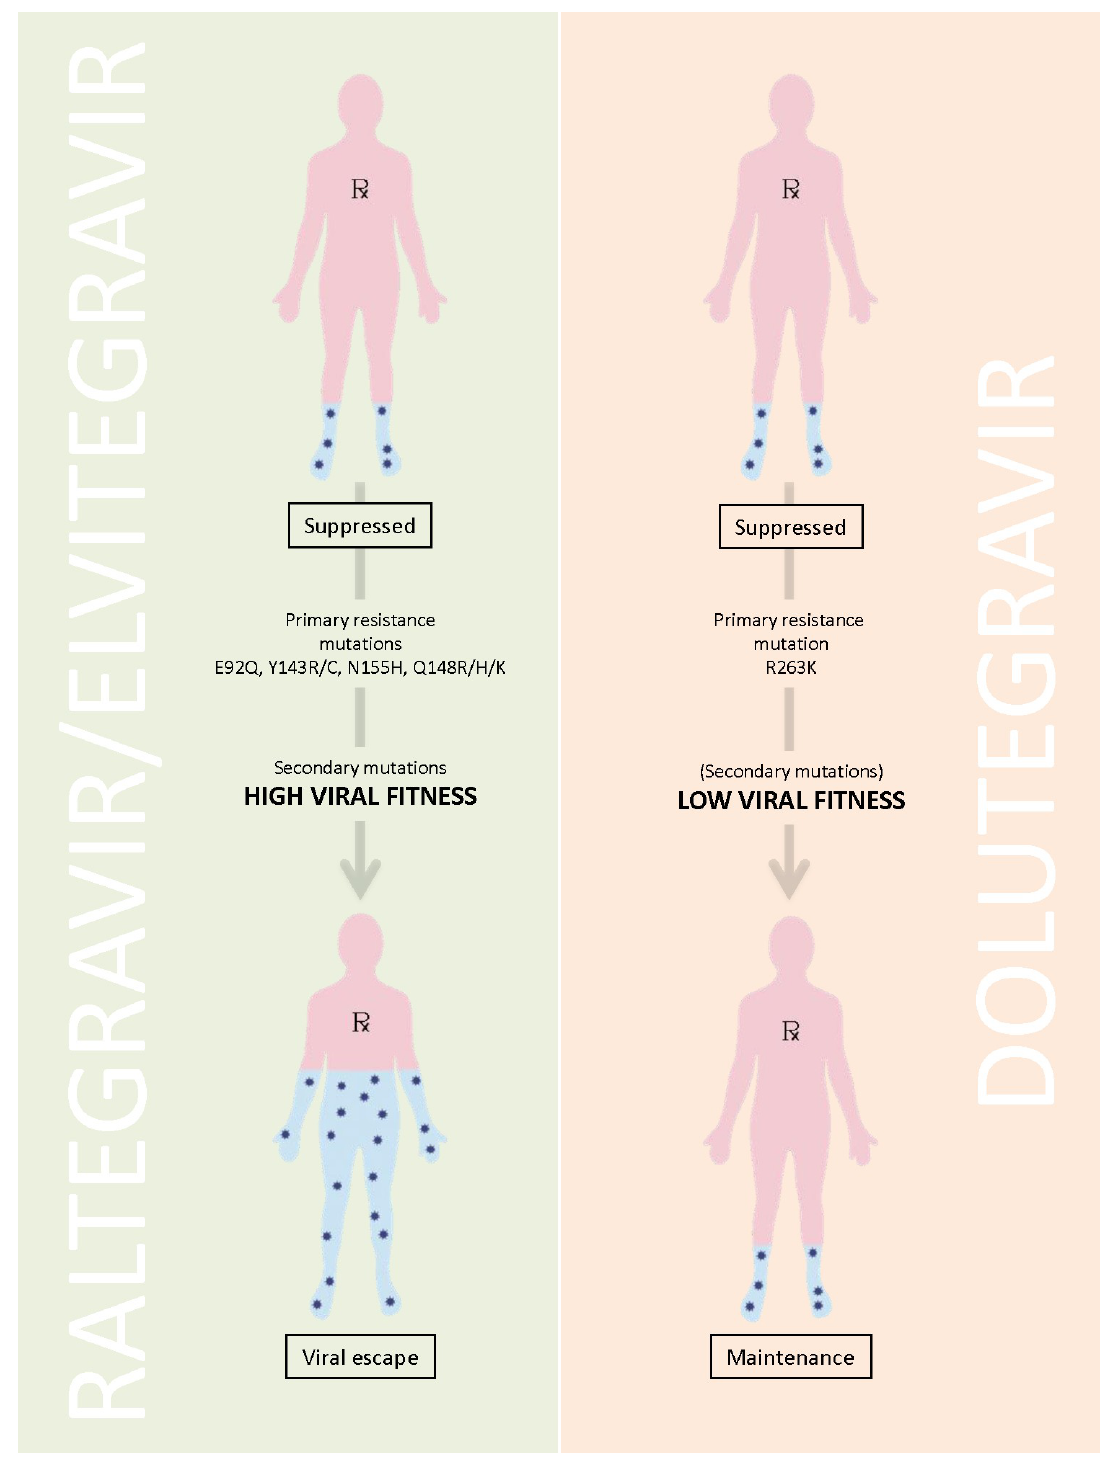
Figure 1. Schema of Low Viral Fitness due to the R263K Resistance